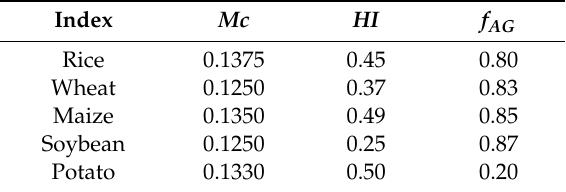
Table 2. The coe ffi cients for estimation of cultivated land Net Primary Productivity (NPP) [50–52]. Index Mc HI f AG Rice 0.1375 0.45 0.80 Wheat 0.1250 0.37 0.83 Maize 0.1350 0.49 0.85 Soybean 0.1250 0.87